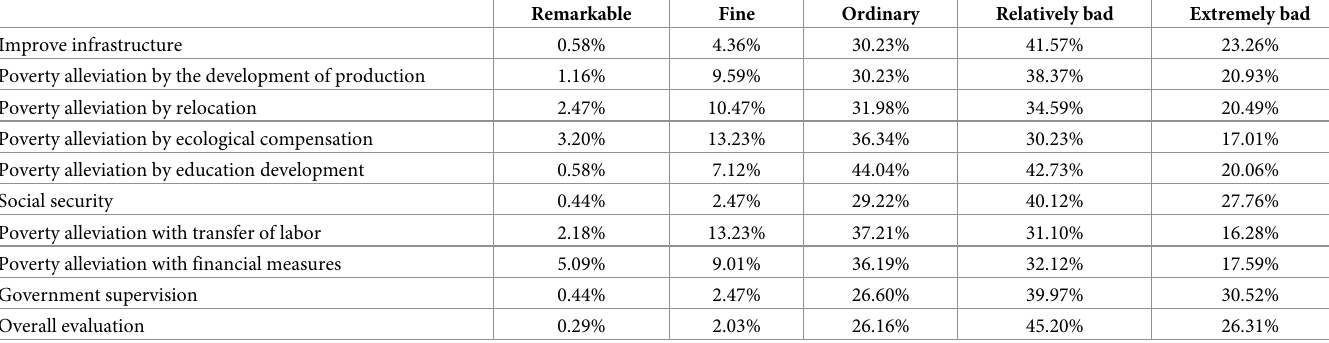
Table 6. Grassroots officials’ evaluations of the governments’ targeted poverty alleviation